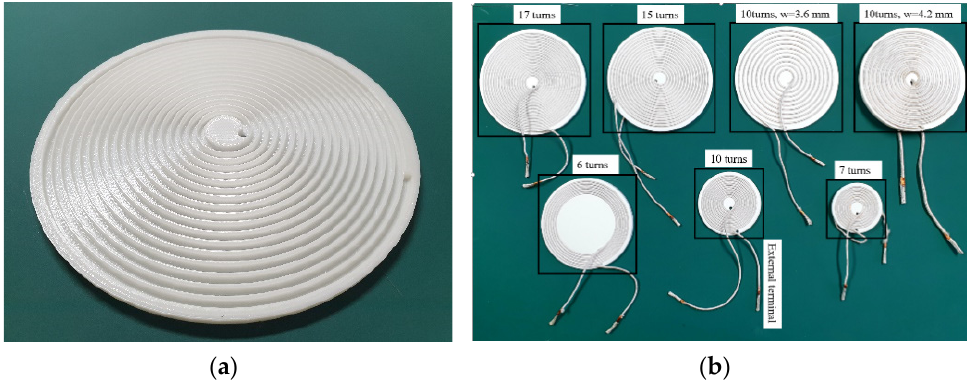
Figure 2. Spiral coil. ( a ) Bobbin ( b ) Spiral coil with bobbin.